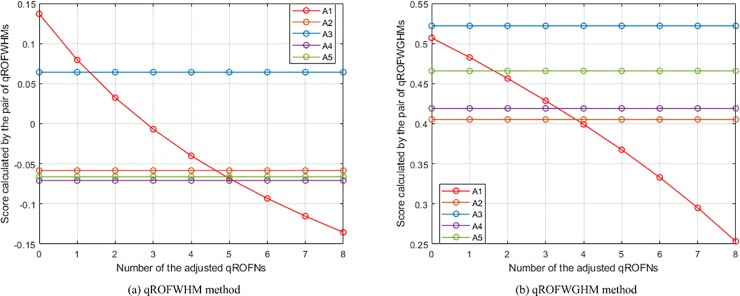
The changes of the places of A1 in the rankings of the WHM and WGHM methods.